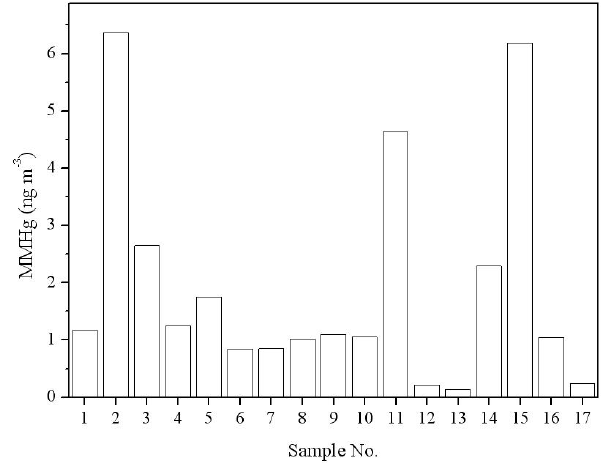
Fig. 9. Comparison of average TGM in the LFG before and after the rainfall event at G-Y landfill. Fig. 10. MMHg in the LFG of selected vent pipes at G-Y landfill.